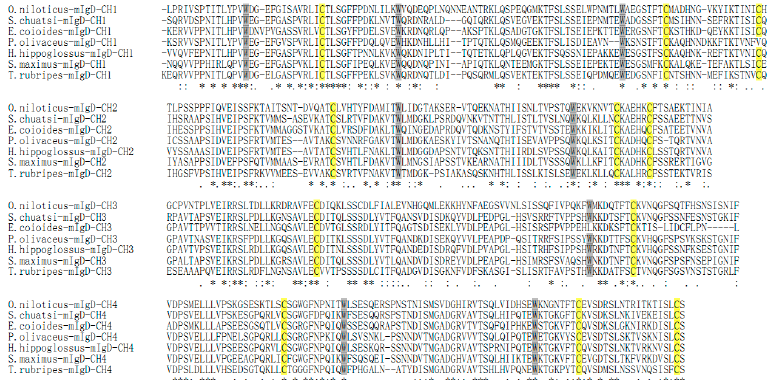
Figure 3. Multiple alignments of the On-mIgD amino acid sequence with other known On-mIgD. Identical residues are indicated with asterisks (*), and similar amino acids are indicated with dots and colons. The conserved cysteine residues predicted important for disulphide linkage are yellow highlight. Tryptophan residues required for the formation and stabilization of the tertiary structure of immunoglobulin are indicated by shades of grey. GenBank accession numbers are as follow: O. niloticus KF530821; S. chuatsi ACO88906.1; E. coioides AFI33218.1; P. olivaceus BAB41204.1; H. hippoglossus AAL79933.1; S. maximus AFQ38975.1; T. rubripes BAD34541.1.